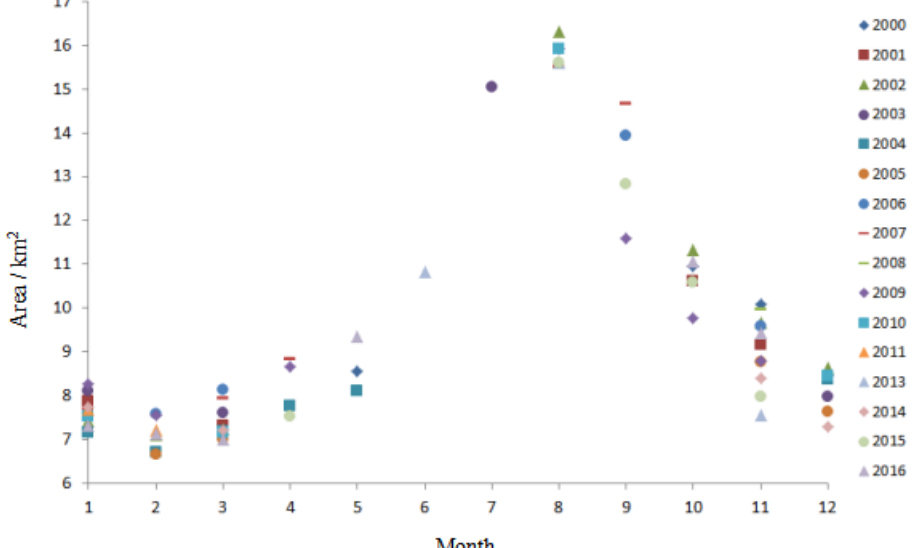
Figure 6. Monthly variation of river area at Nuxia Hydrological Station from 2000 to 2016